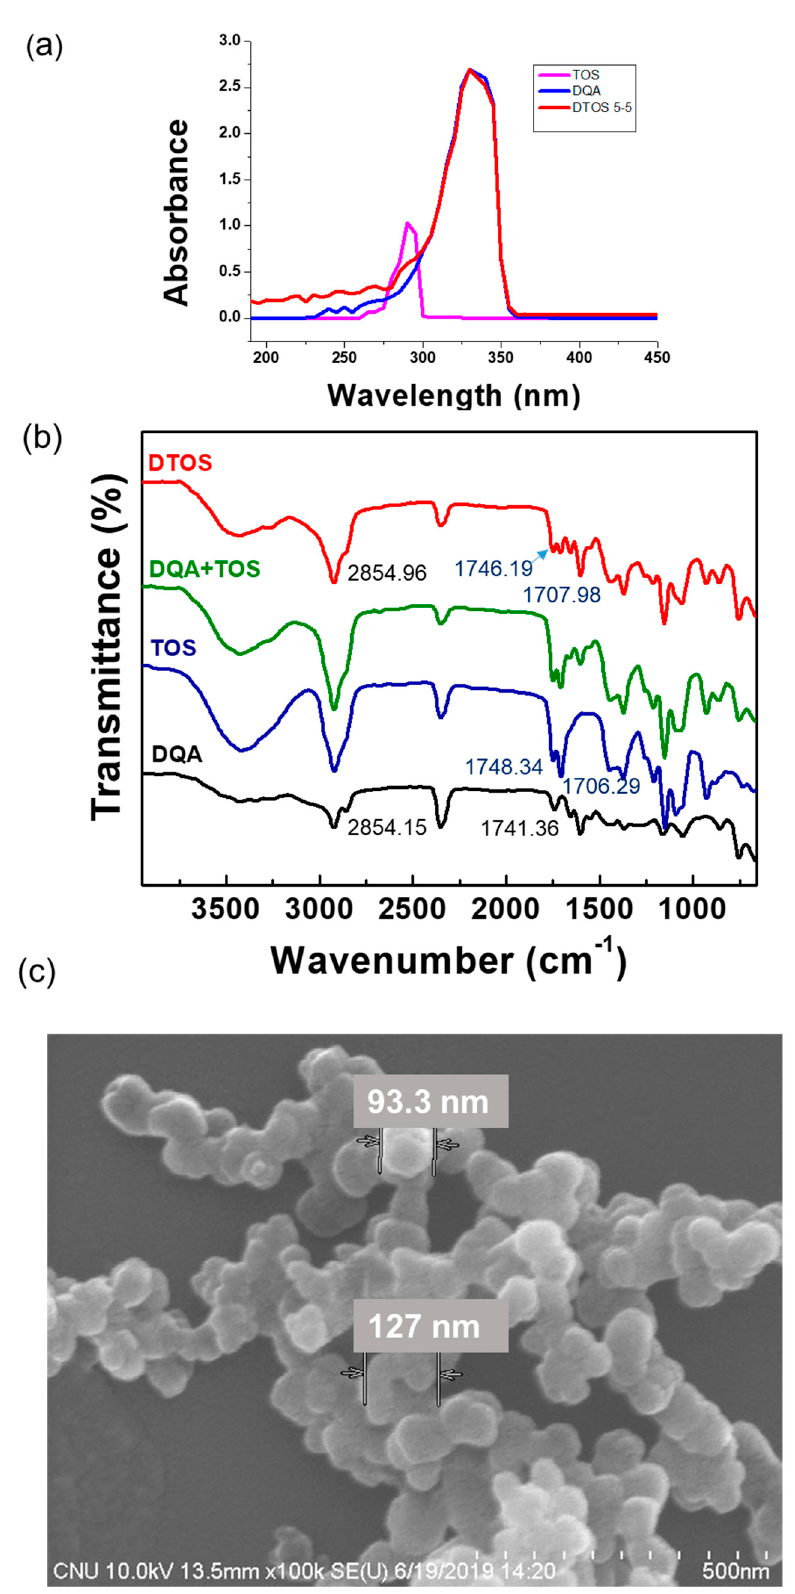
Figure 4. ( a ) UV-Vis absorption spectra of α -TOS, DQA, and DTOS emulsions. ( b ) FTIR spectra of α -TOS, DQA, the mixture of DQA and α -TOS, and DTOS emulsions. ( c ) Field emission scanning electron microscopy of DTOS 5-5.